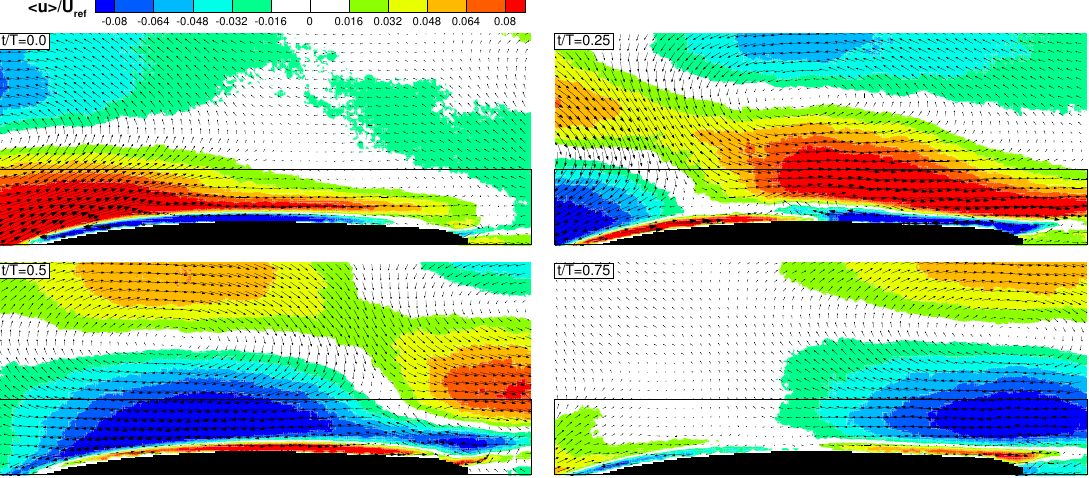
Figure 4. Phase-averaged velocity vector maps with superimposed the streamwise velocity contour for the nominal f +